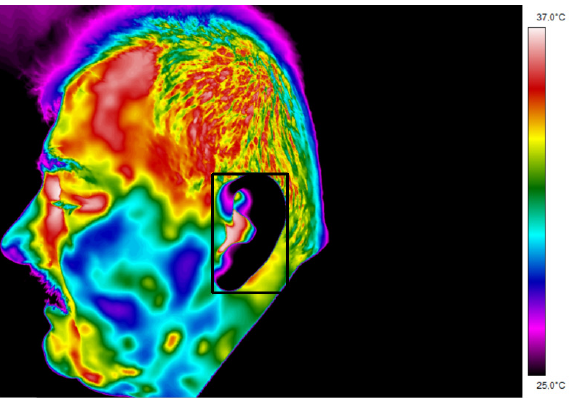
Figure 4. Thermogram 1 showing the temperature map of the subject’s lateral facial surface. Thermogram 2 shows the temperature map of a face aligned with respect to the lens of the thermal camera in the AP projection. The area of interest containing the external auditory canal from which the maximum temperature was read was marked on the ther- mogram.